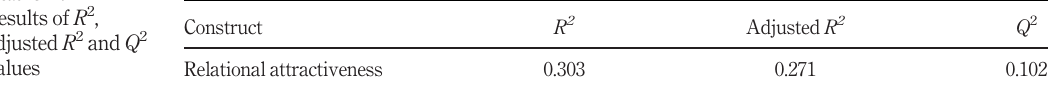
Figure 2. Complete empirical